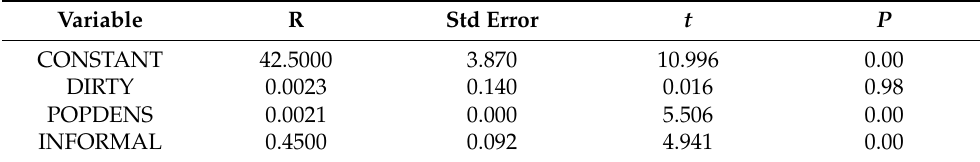
Table 3. Land use type regression output.